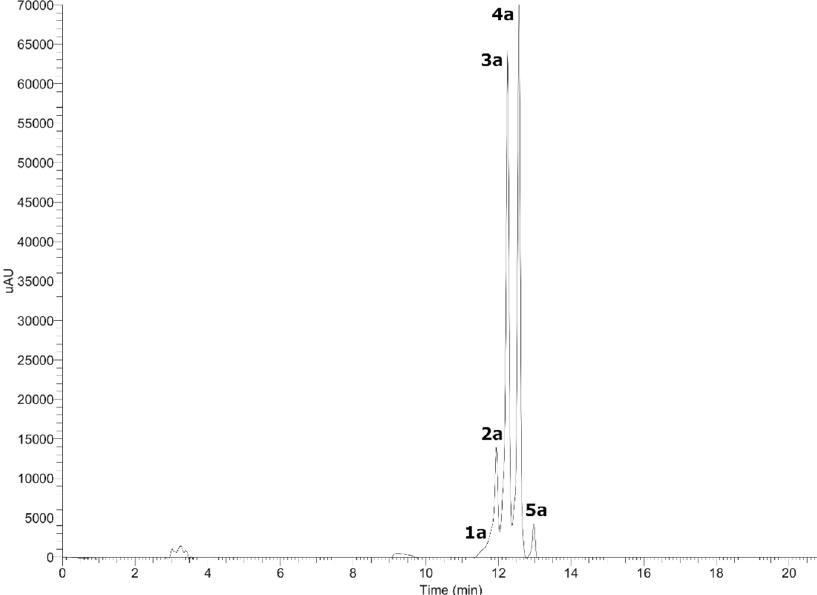
Figure 2. UHPLC-DAD chromatogram of anthocyanins from Gaultheria pumila at 520 nm.